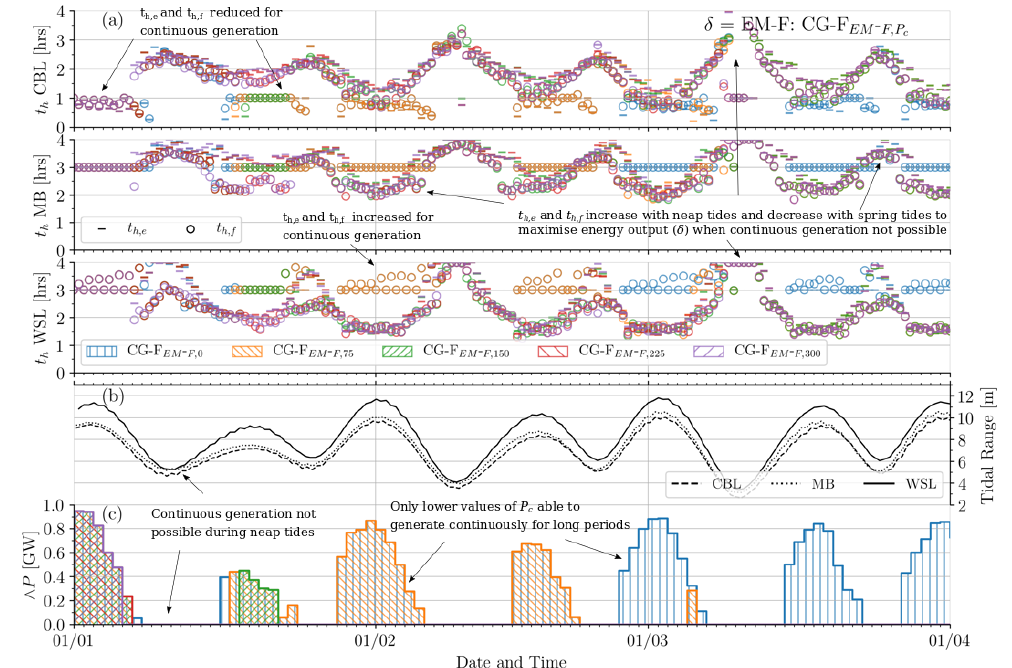
Figure 8. Temporal operation characteristics of the tidal power plant system in applying flexible controls to optimise towards continuous generation, with δ = EM-F, a flexible energy maximisation default (CG-I EM - F , P ). For all three power plants, ( a ) indicates holding periods t h , e and t h , f per tidal c cycle ( b ) the tidal range each cycle and ( c ) daily cumulative minimum power output ∧ P